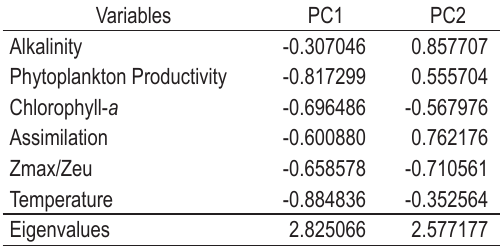
Table 2. Eigenvalues and variables’ loadings for the principal component (PC) analysis.